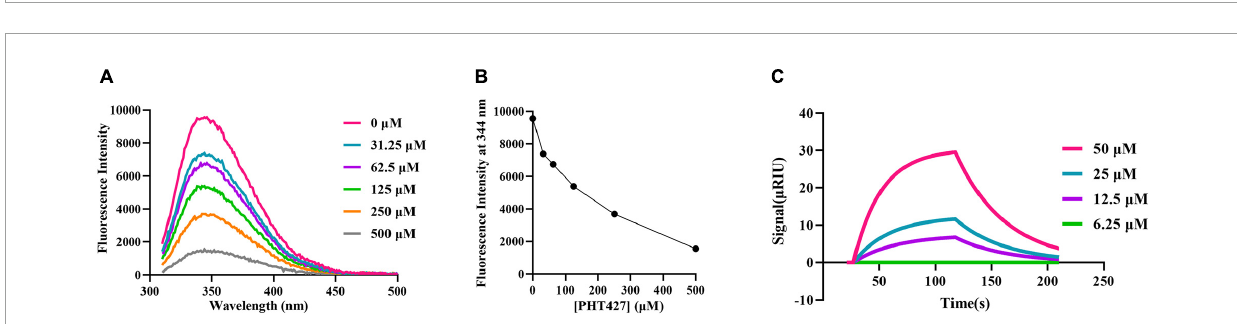
FIGURE2 Confirming the interaction between PHT427 and NDM-1. (A) Variation of the intrinsic fluorescence spectra of NDM-1. The excitation wavelength was 270 nm, and emission spectra were acquired by scanning from 310 to 490 nm. (B) PHT427 quenches the intrinsic fluorescence of NDM-1 in a concentration dependent manner. (C) Binding sensorgrams of PHT427. NDM-1 was immobilized to a CM5 chip by amine coupling and the figure was generated by SPR analysis software called